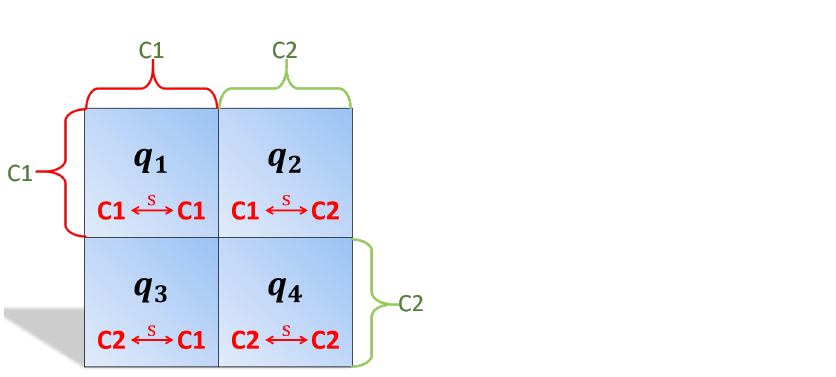
Figure 1. Four quadrants for a supervised two class kernel matrix. The similarity represented in each quadrant is denoted with respect to class. C1: class 1, C2: class 2, and s Ø : similarity